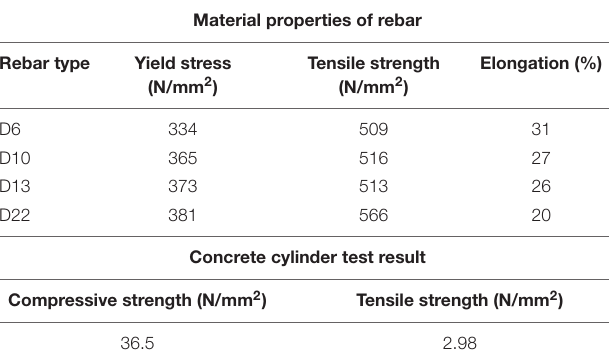
Frontiers in Built Environment |